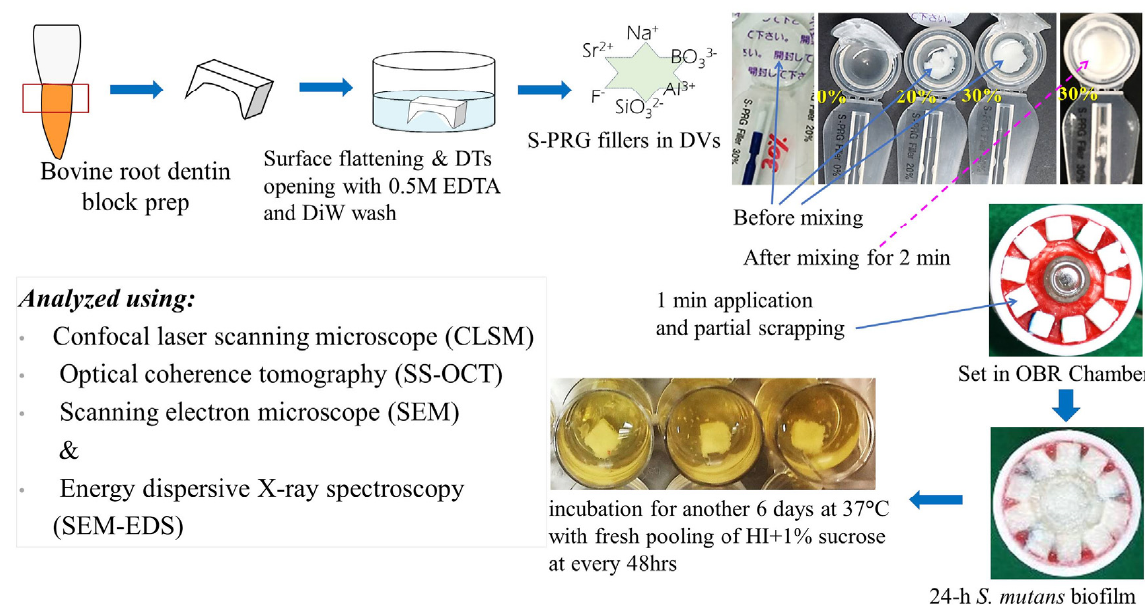
Figure 1. Schematic diagram shows the protocol of the study: specimen preparation, adequate mixing of active and base ingredients of each DV and application, biofilm attack for 7 days after setting of the DV materials, followed by evaluation of the effects of different DVs using CLSM, SS-OCT, SEM, and EDS. Note: each DV preparation is delivered in an air-tight sealed-pack with base and active parts together in an unmixed condition. Abbreviations: DT; dentinal tubules, DiW; de-ionized water,